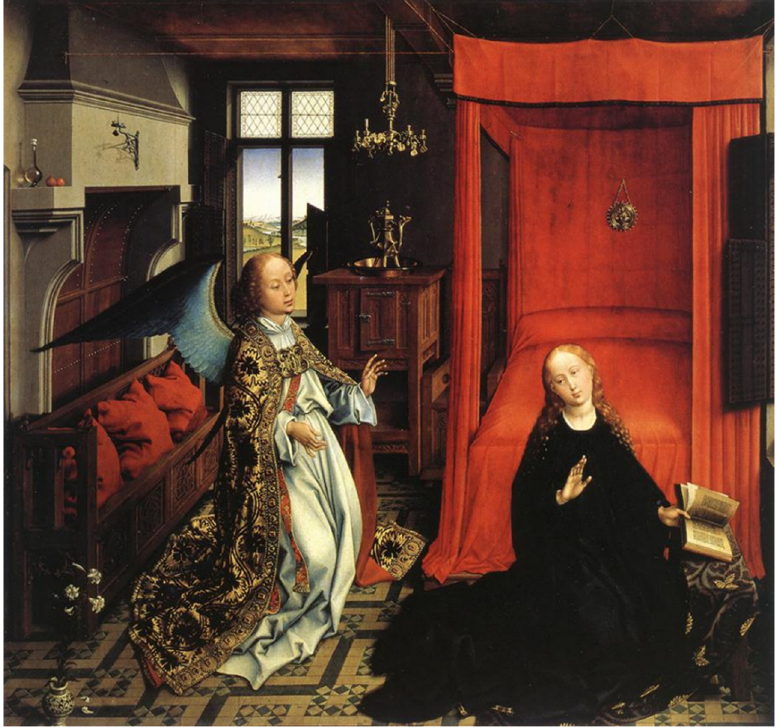
Figure 2. Rogier van der Weyden and workshop, Annunciation , ca. 1435–1440. Oil on oak, 86 × 93 cm. Paris, Musée du Louvre. © Wikipedia Commons, https://upload.wikimedia.org/wikipedia/commons/3/35/Rogier_van_der_Weyden_-_The_Annunciation_-_WGA25591.jpg (accessed on 29 October 2021).